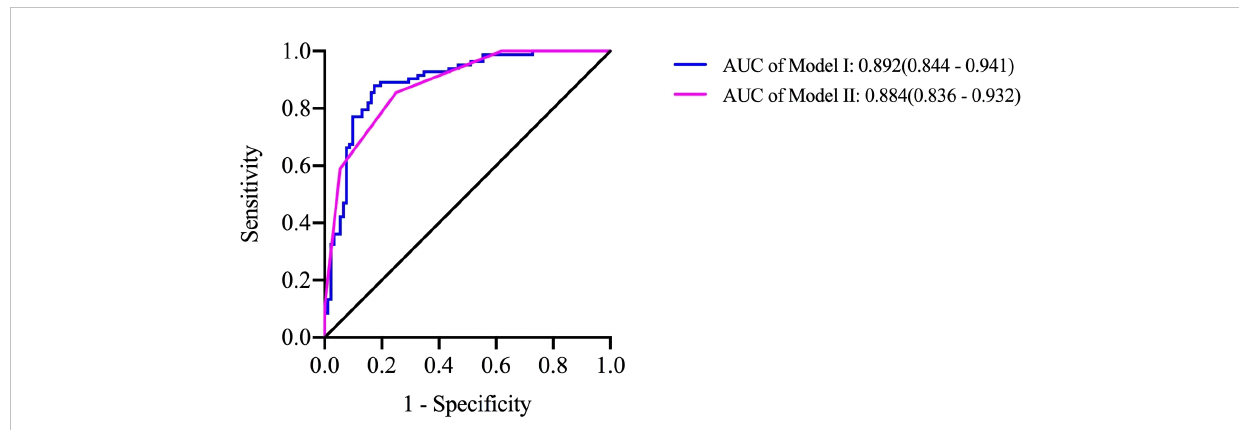
FIGURE 1 A predictive model for identifying diseases resulting in secondary HLH. Risk factors were used to produce the receiver operating characteristic curves Model I =1.427×Female-0.048×Age-0.820×Splenomegaly+0.024×HBG+0.009×PLT+0.022×Ferritin +3.810×EBV negativity-4.464; Model II =1×Female+1×Age+1×PLT+1×Ferritin +2×EBV negativity. When Model II ≥ 4, the sensitivity of predicting HLH secondary to rheumatic disease was 85.5% and the speci fi city was